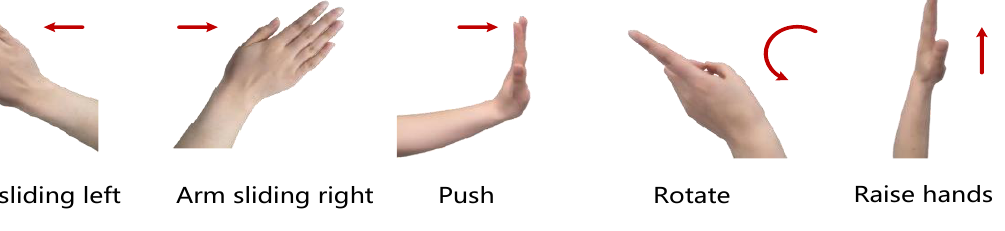
Figure 3. Hand gestures.